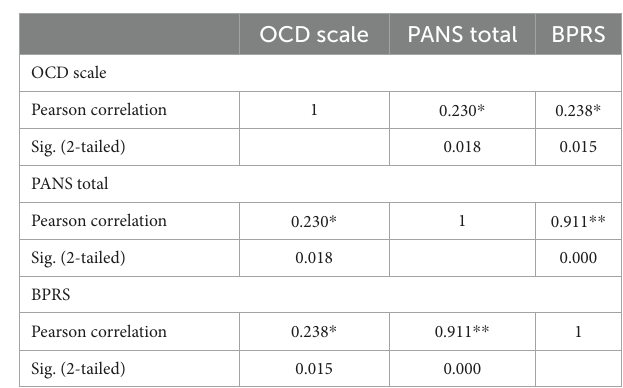
TABLE 2 Relationship between OC symptoms assessed by DOCS and the PANSS and BPRS